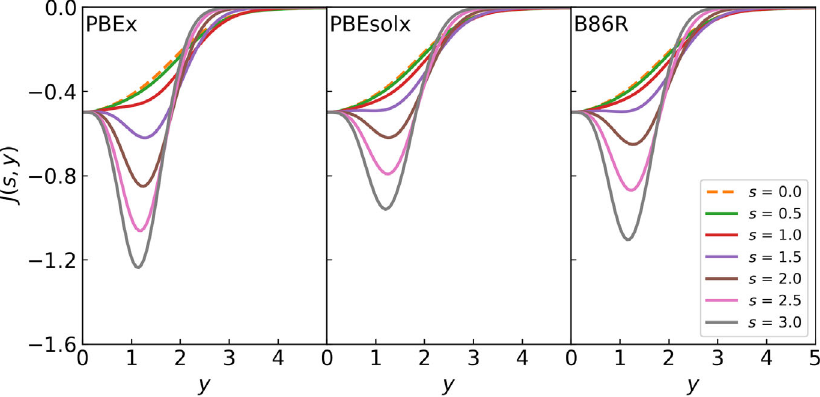
FIG. 3. Radial variation in the scaled exchange hole J ð s; y ¼ k F ð r Þj r − r 0 jÞ ¼ n x ð r ; r 0 Þ =n ð r Þ for PBE, PBEsol, and B86R, all as described in an AH model parametrization [17,91]. The shapes of these holes define the exchange components of PBE [50], PBEsol [51], and B86R, respectively. Using the latter exchange-hole model, we define the here-released RSH AHBR following the design steps that we recently documented in crafting AHCX